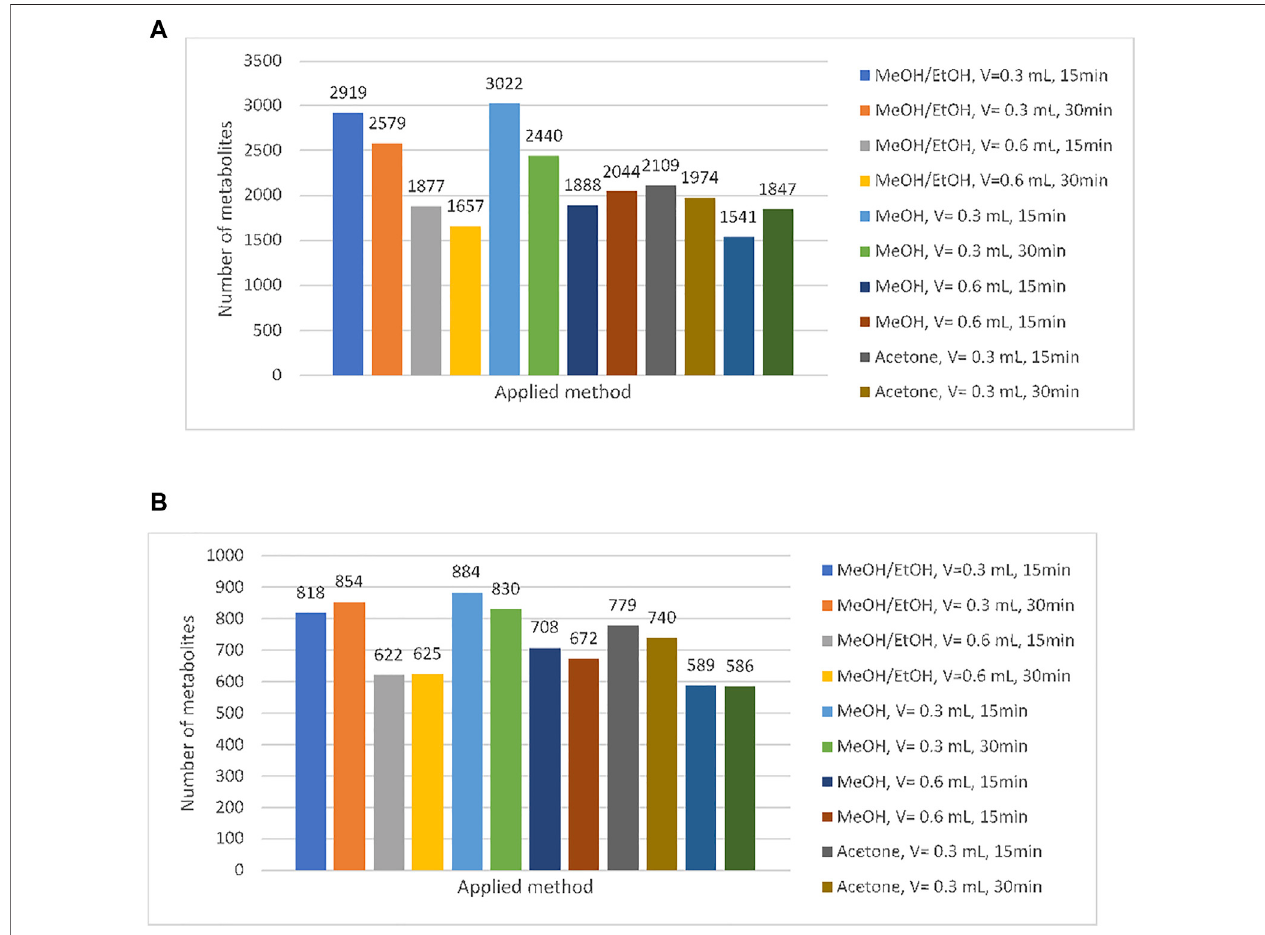
FIGURE 3 | Number of compounds in reference to applied method (CV < 30%) (A) and number of compounds regarding the presence in all analyzed replication and developed method (B) .